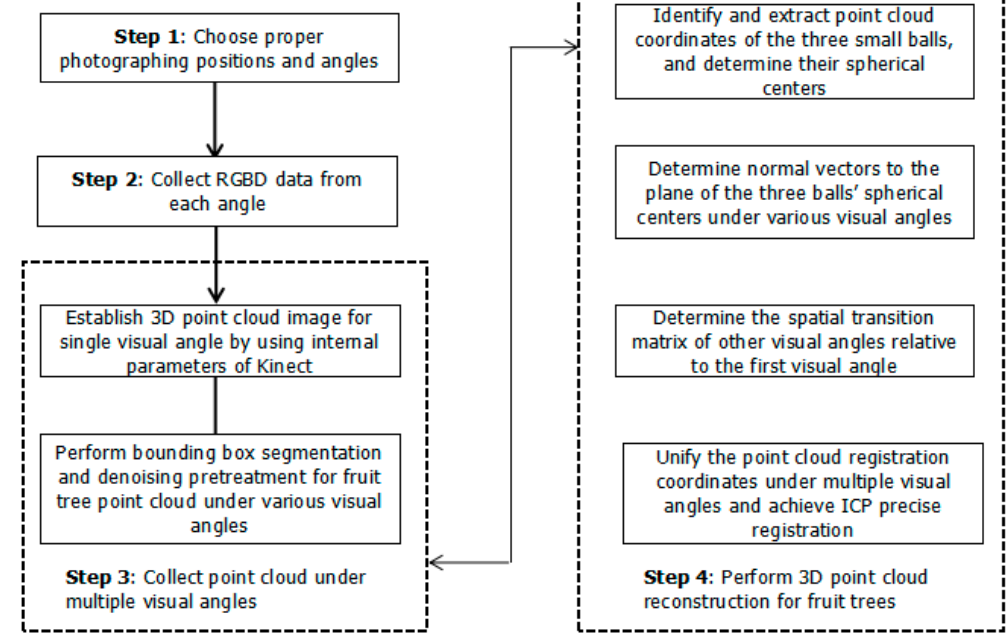
Figure 2. Diagram of three-dimensional (3D) reconstruction methodology.